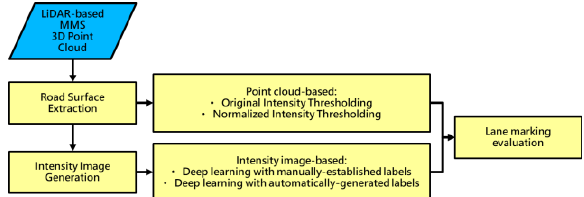
Figure 4. Flowchart of the proposed framework for lane marking